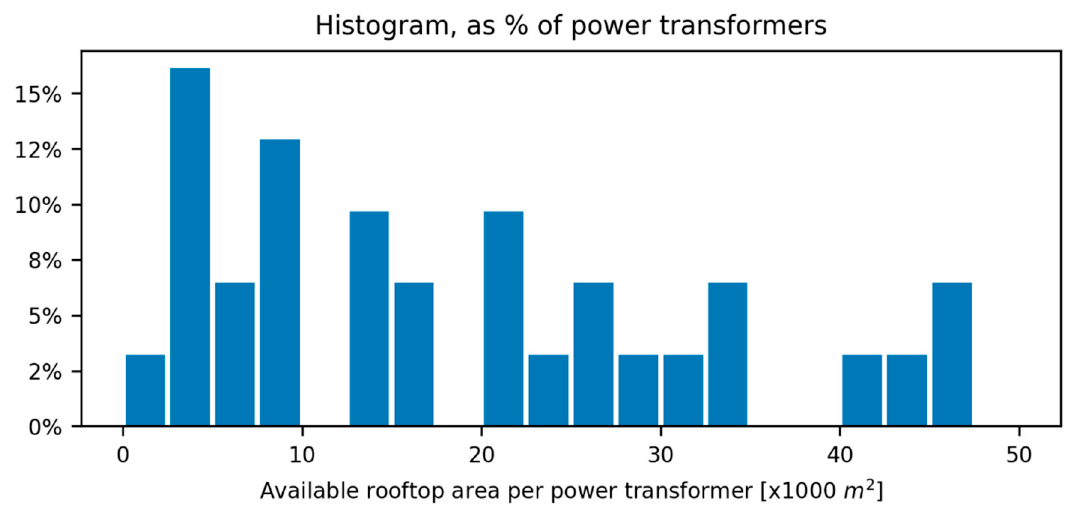
Figure 7. Available rooftop area distribution for the Voronoi polygons associated to each of the considered power transformers.